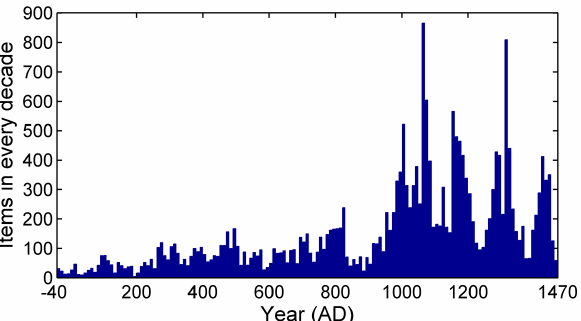
Figure 4. The amount of climatic information extracted from Chi- nese classical documents (a reproduction of Fig. 7 in Ge et al.,